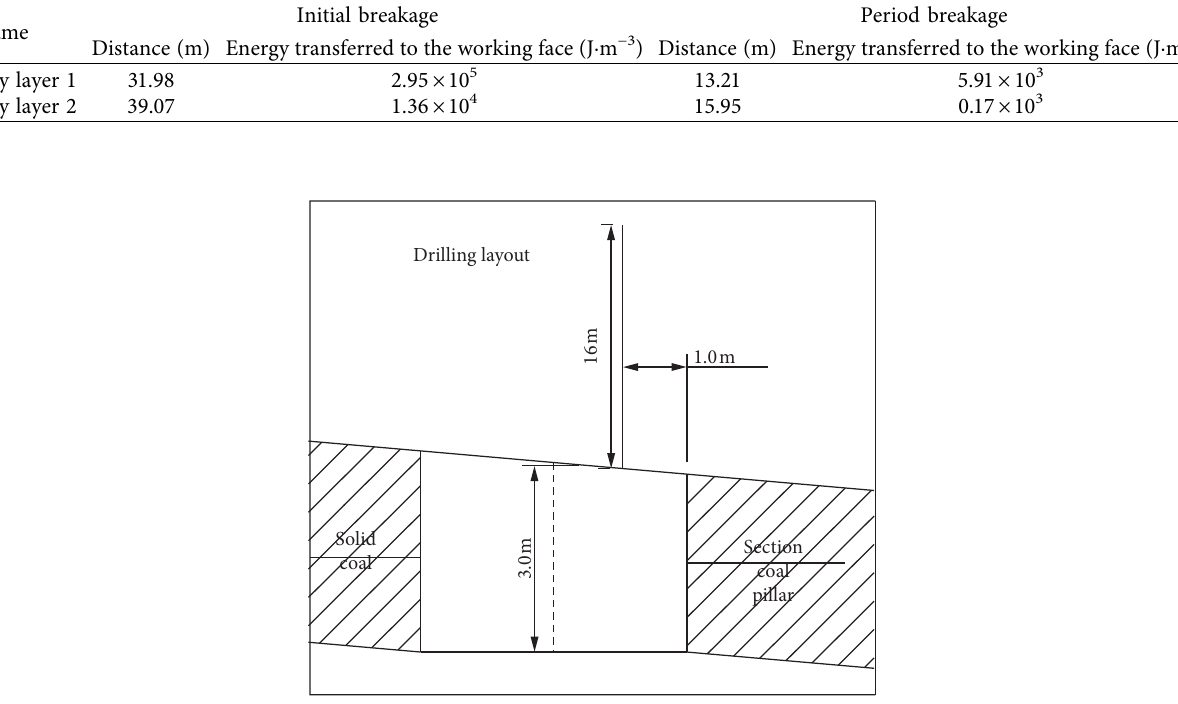
Figure 5: Diagram of rock burst management in LW